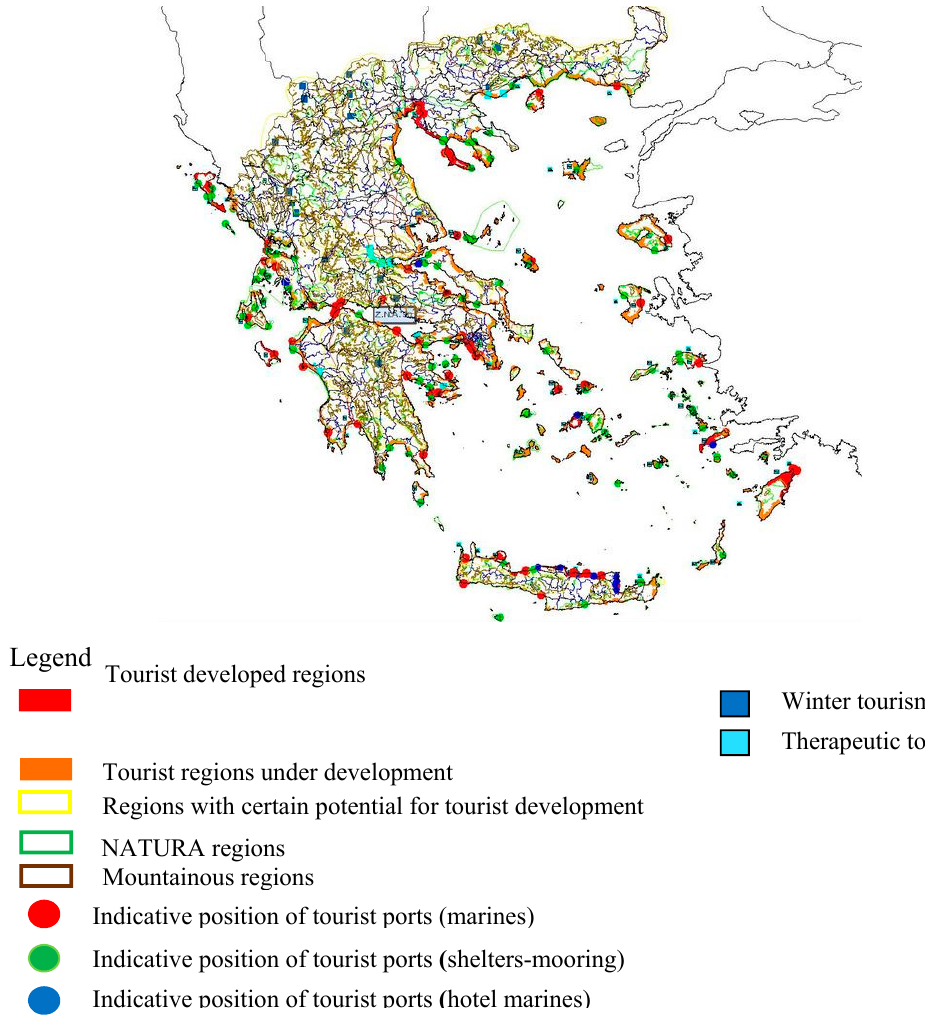
Figure 4. The proposed spatial development of the tourist sector entering the e-consultation process [43], CC BY 3.0